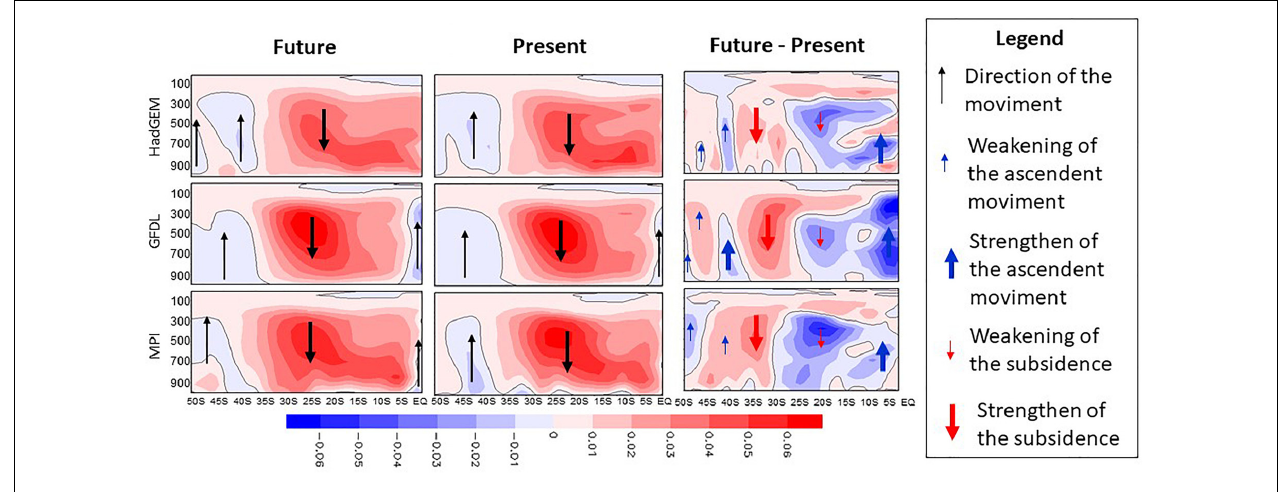
FIGURE 10 | Similar to Figure 9 but for